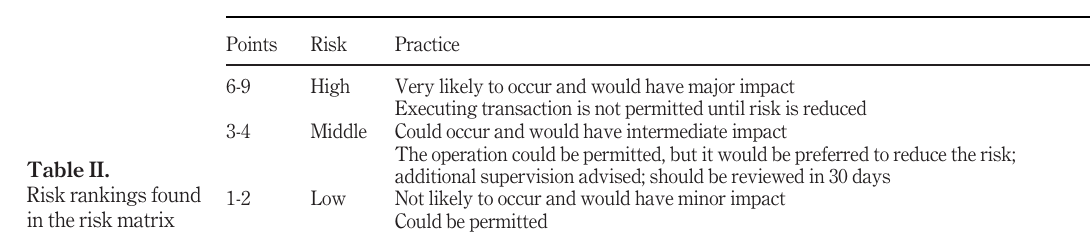
Table I. Risk matrix